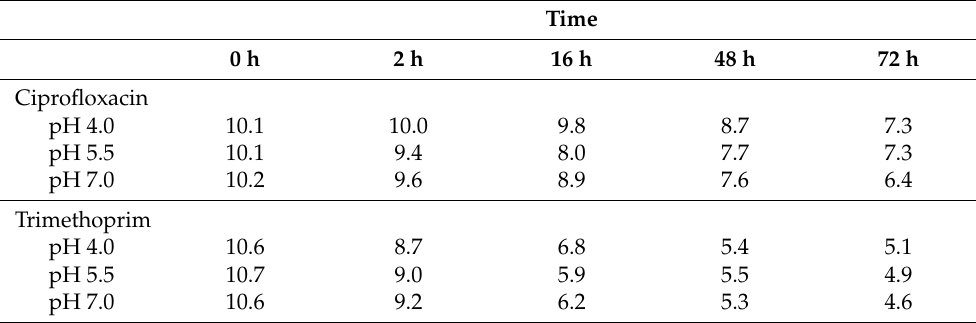
Table 4. Values of total organic carbon (TOC, mg L − 1 ) at different times of exposure. to simulated light and at different pH